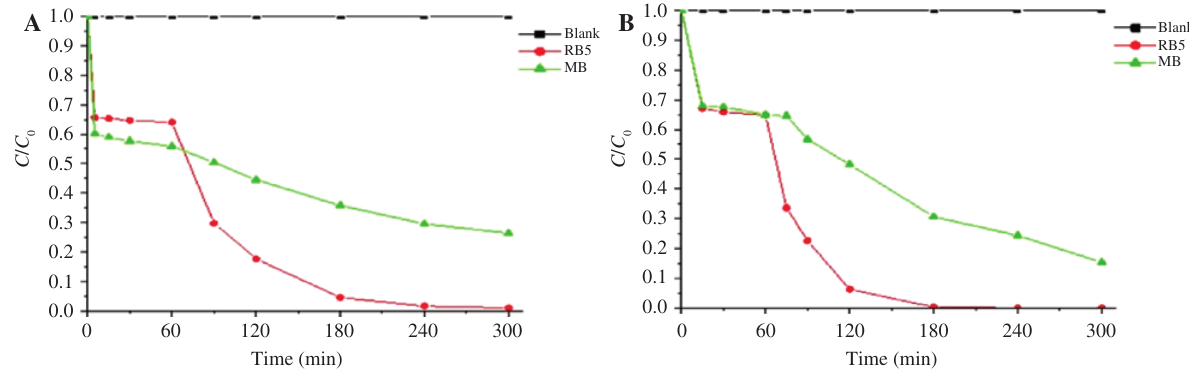
Figure 12: Photocatalytic decolorization of reactive black 5 and methylene blue dyes under (A) visible light (B) direct sunlight irradiation.